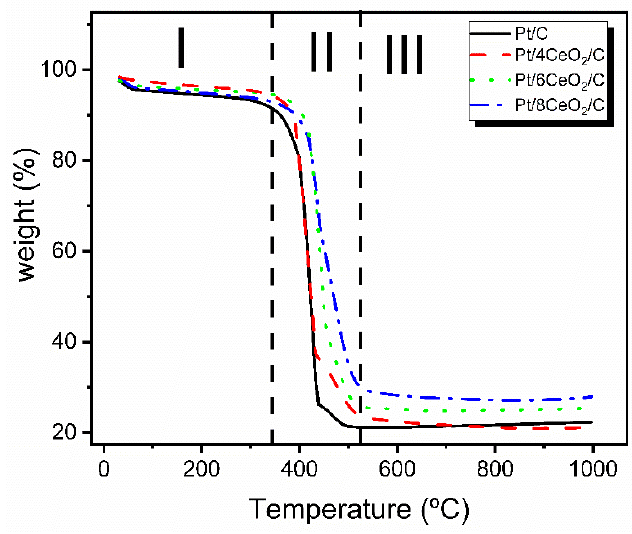
Figure 1. Thermogravimetric analyses of Pt/C and Pt/CeO 2 /C catalysts. The measurements were performed in air atmosphere up to 1000 ◦ C with a heating ramp of 10 ◦ C min − 1 .